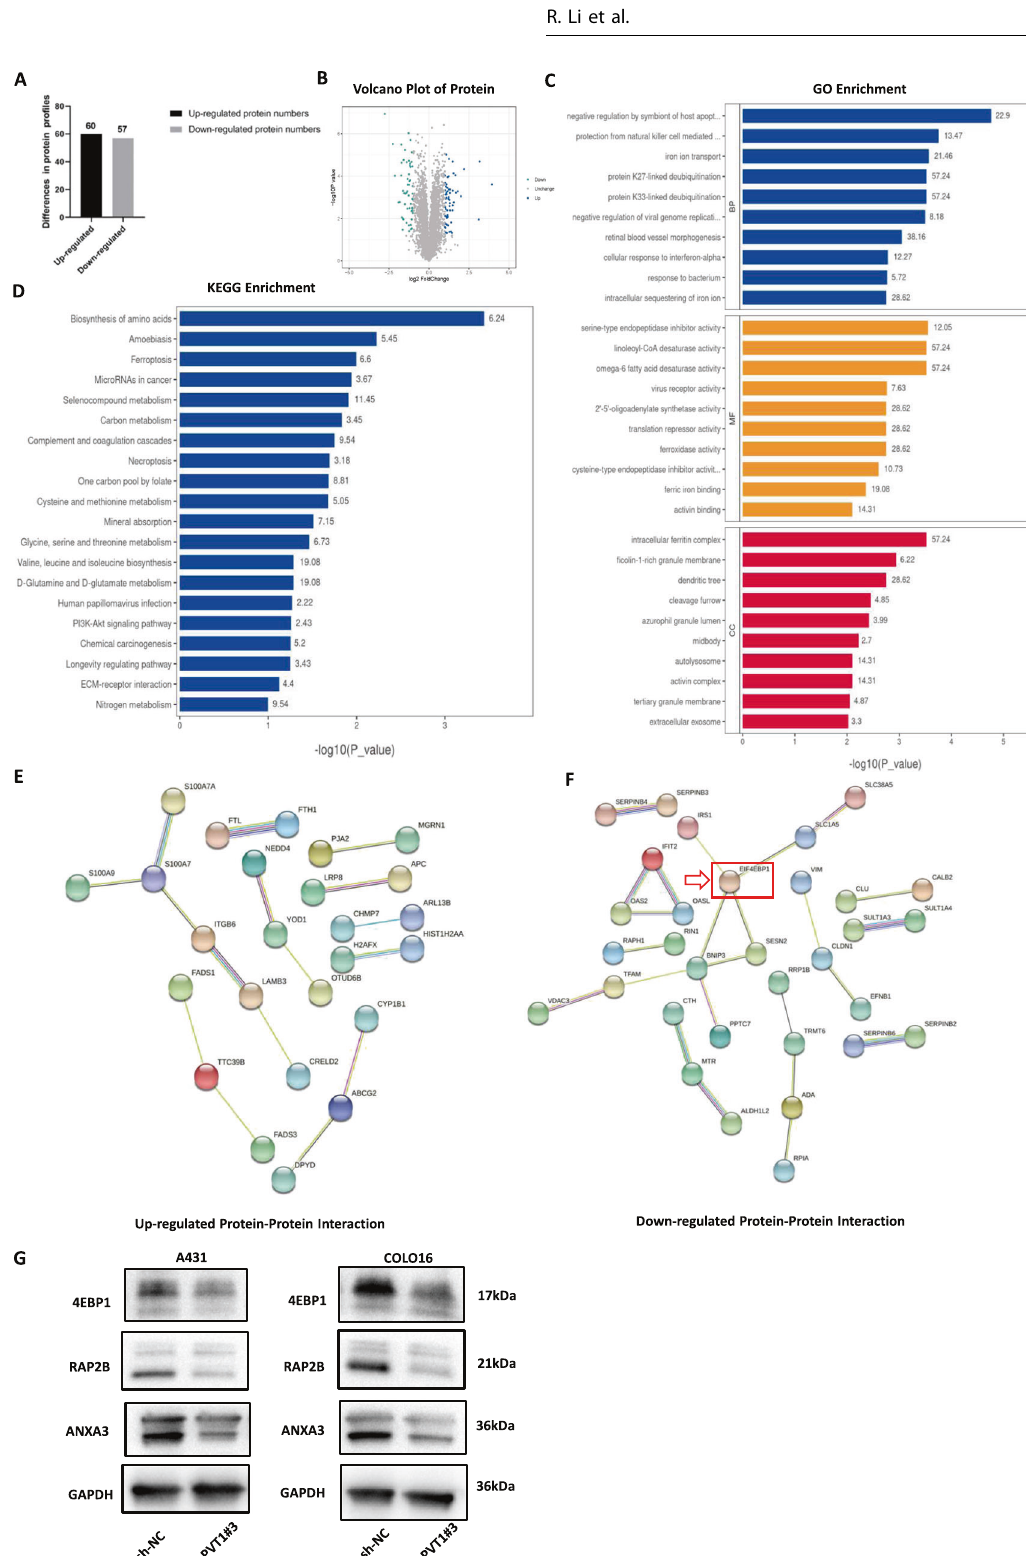
Fig. 5 Label-free quantitative proteomics and bioinformatics analysis in A431 cell. A , B A total of 117 signi fi cant DEPs was detected by label-free quantitative proteomics in A431 cSCC cells. C , D KEGG and GO analysis of DEPs associated with cSCC. KEGG enrichment presents the top 20 enriched pathway of DEPs in cSCC. GO enrichment shows the aspects of DEPs categorized by biological process (BP), molecular function (MF), and cellular component (CC). E , F Images of up- and downregulated PPI networks are shown. 4EBP1 protein is indicated by red arrows. G RAP2B, ANXA3, and 4EBP1 protein expression measured by WB.